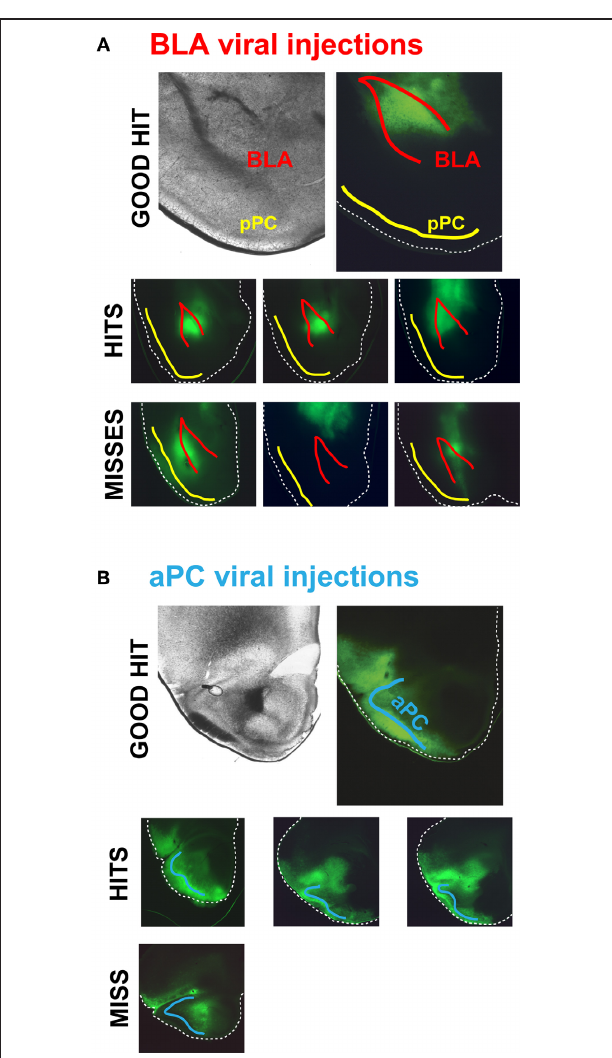
FIGURE 1 | ChR2-AAV injections in and outside of the BLA and aPC. (A) Top row , An example of an ideal BLA injection. Middle row , Examples of common on-target BLA injections in different mouse brains. ChR2-AAV was specifically infected in the BLA in ∼ 25% of the injected mice. Bottom row , Examples of the most common off-target BLA injections. These mouse brains were not used for experiments. (B) Top row , An example of an ideal ChR2-AAV injection in the aPC. Middle row , Examples of typical on-target aPC injections in different mouse brains. The aPC was successfully infected with ChR2-AAV in ∼ 90% of injected mice. Bottom row , An example of the rare off-target aPC